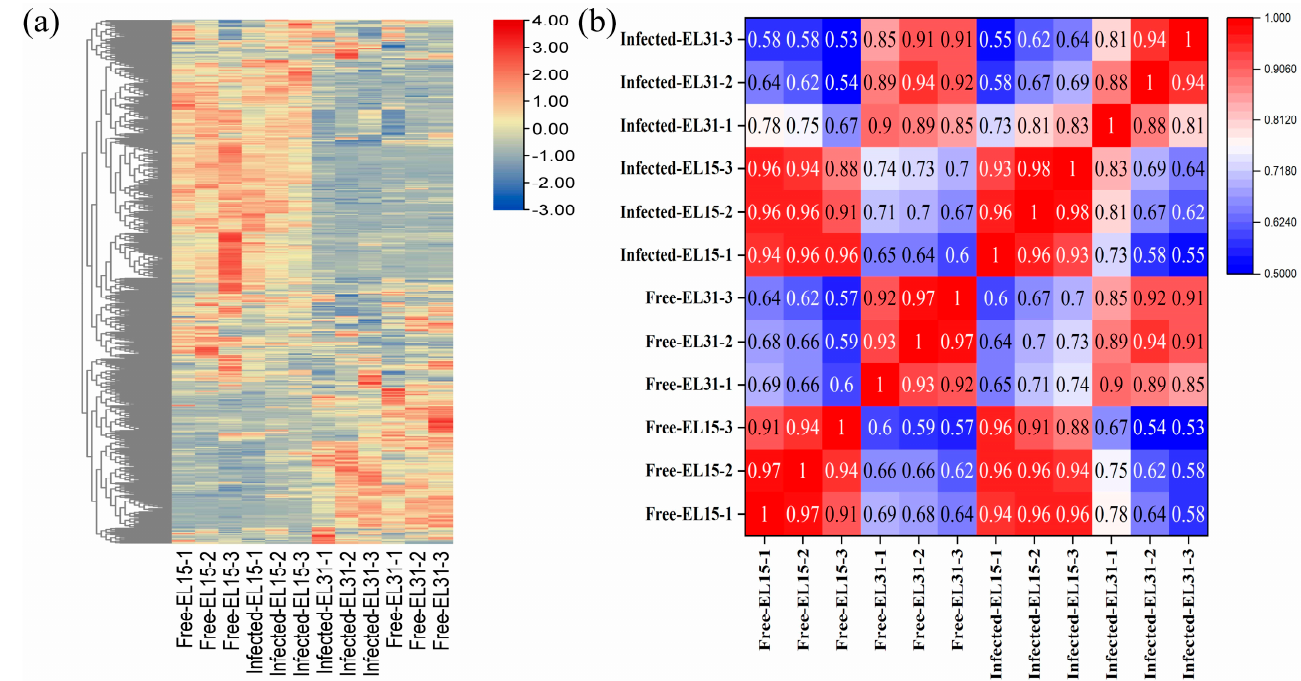
Figure 6. Multivariate statistical analysis of metabolites in leaves. ( a ) Heatmap of the 595 metabolites. Red represents up − regulation, and blue represents down − regulation; ( b ) Pearson correlation coefficients of the twelve leaf samples.